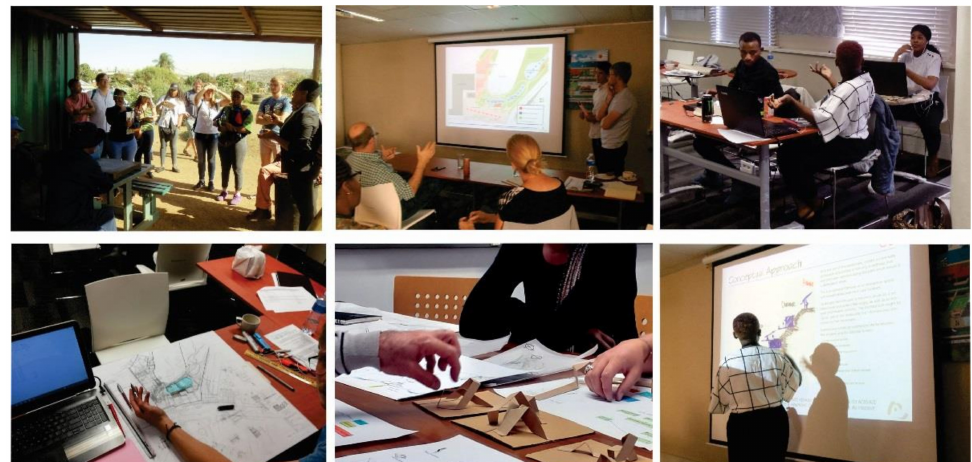
Figure 7. Workshop activities and discussions between the community, municipal staff, and students during the student visit to eThekwini (top) and back in Pretoria (bottom). Source: Author,